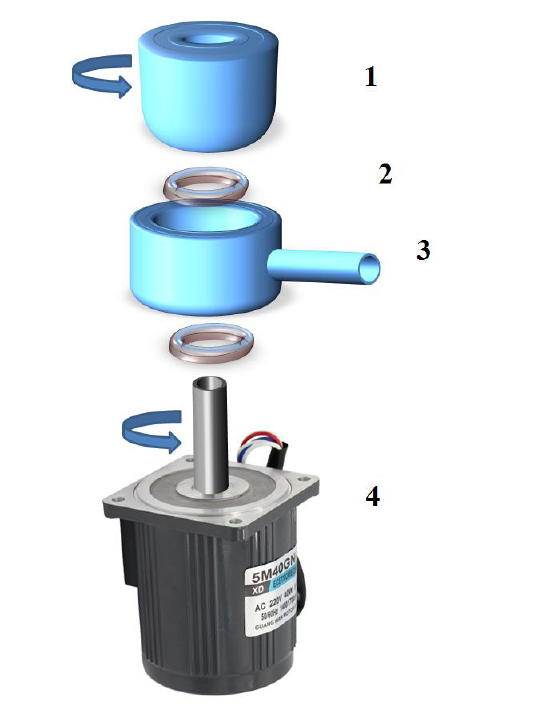
Figure 2. 3D design of fabricated spin coater (1) substrate holder, (2) O ring, (3) vacuum channel and (4)